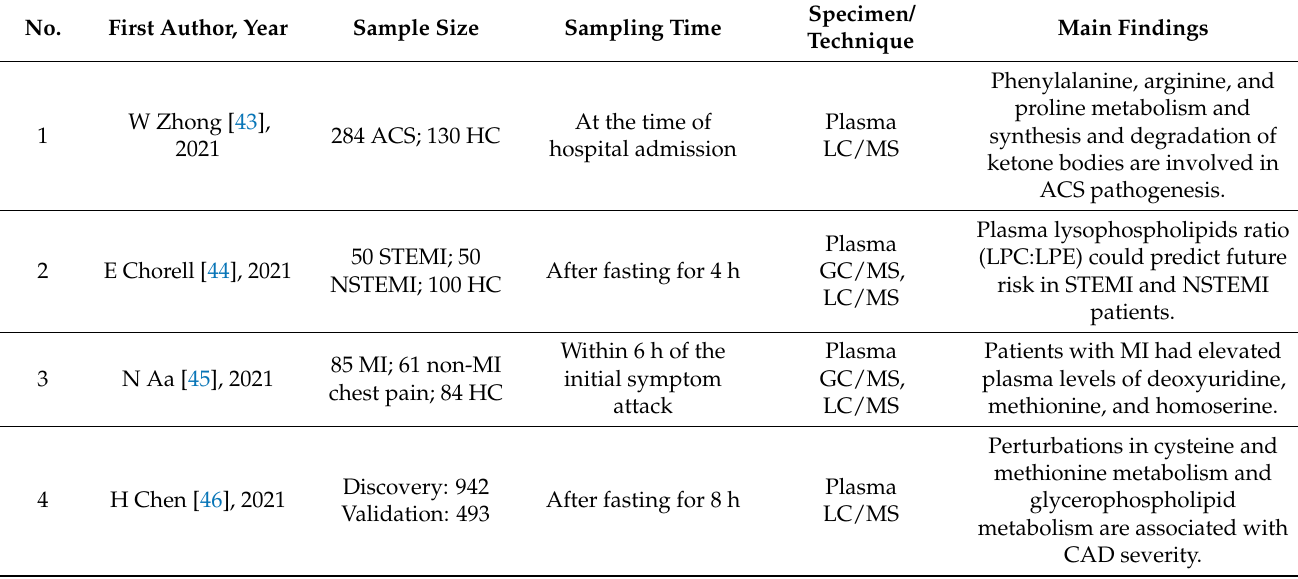
Table 2. Main findings from the clinical studies of metabolomics in acute coronary